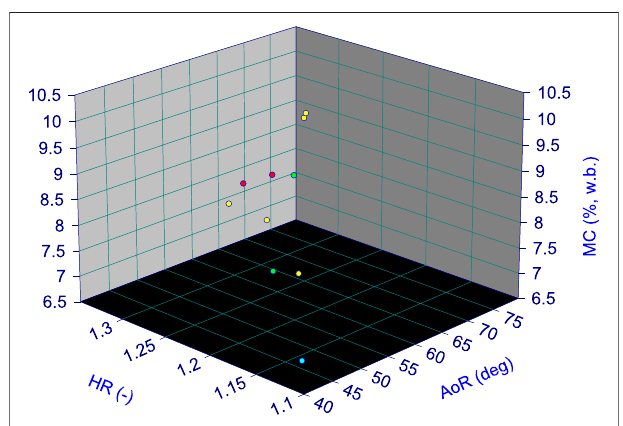
FIGURE 4 | Examining DDGS moisture content, angle of repose, and Hausner Ratio (PBD/LBD) can be used to predict fl owability problems, as described by Bhadra et al.